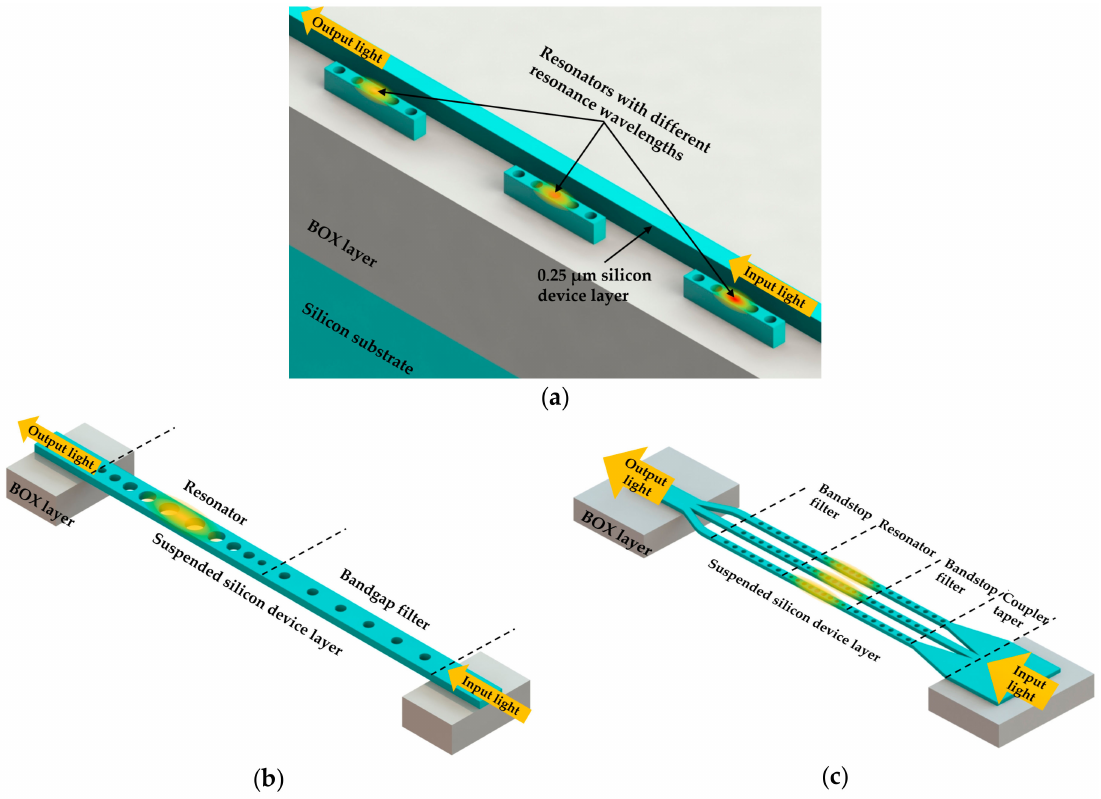
Figure 9. Proposed sensors for multiplex sensing: ( a ) waveguide side-coupled nanobeam cavity array; ( b ) schematic of nanobeam cavity integrated with bandgap filter; ( c ) parallel multiplex sensing array integrated with band stop